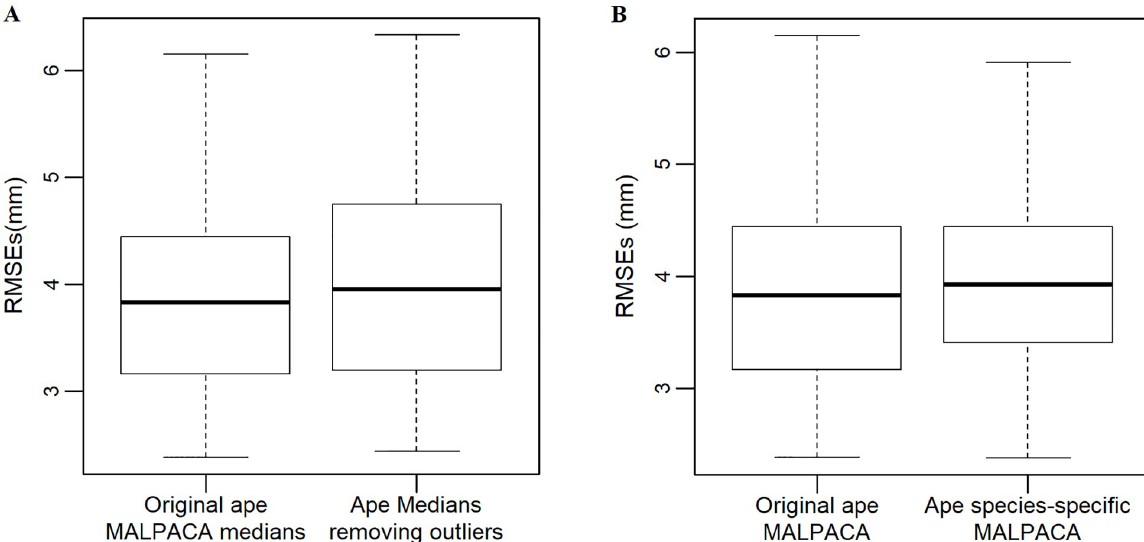
Fig 10. RMSEs comparison boxplots for ape refined MALPACAs. (A) The boxplot for comparing the performance of the ape MALPACA and the new median estimates achieved after removing outlier estimates demonstrated in S8 Fig. Comparison is based on calculating RMSEs between estimates and the GS. Two-sided Welch t-test shows that the RMSEs yielded from these two analyses are not significantly different with a p-value 0.5751. (B) RMSEs between the original ape MALPACA and “species-specific” MALPACA for the ape sample. Species-specific MALPACA refers to performing a MALPACA for one species only using templates of that species. RMSEs are calculated between estimates and the